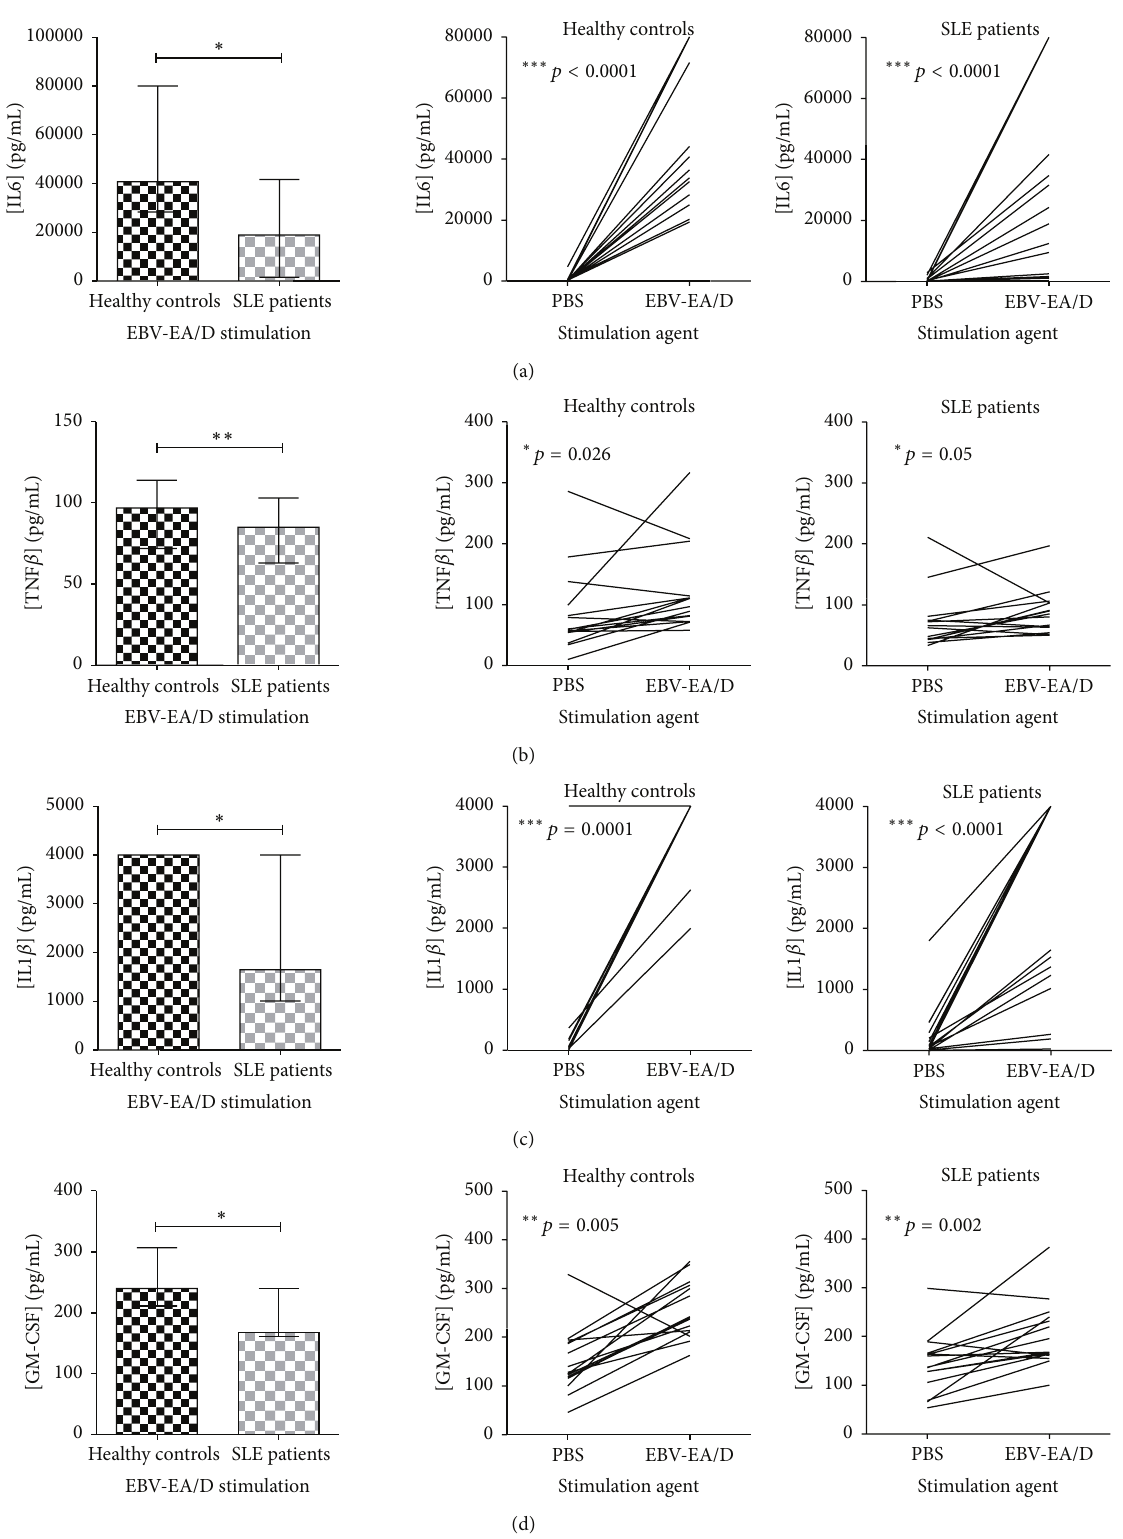
Figure5:DecreasedinductionofIL6(a),TNF 𝛽 (b),IL1 𝛽 (c),andGM-CSF(d)inSLEpatientscomparedtoHCsuponEBV-EA/Dstimulation. IL6(a),TNF 𝛽 (b),IL1 𝛽 (c),andGM-CSF(d)quantifiedindriedbloodspotsamplesfromSLEpatients(withnormallymphocytelevels, 𝑛 = 15 ) and sex- and age-matched HCs ( 𝑛 = 15 ) by multiplexed Luminex assay with addition of HBR+. Left: cytokine concentrations (pg/mL) in SLE patients and HCs upon EBV-EA/D stimulation. Data are presented as median with interquartile range. 𝑝 values for comparison of SLE patients and HCs are 0.033, 0.010, 0.020, and 0.018 in (a), (b), (c), and (d), respectively. Right: induction of cytokines (pg/mL) from basic levels (PBS stimulation) by EBV-EA/D stimulation in SLE patients and